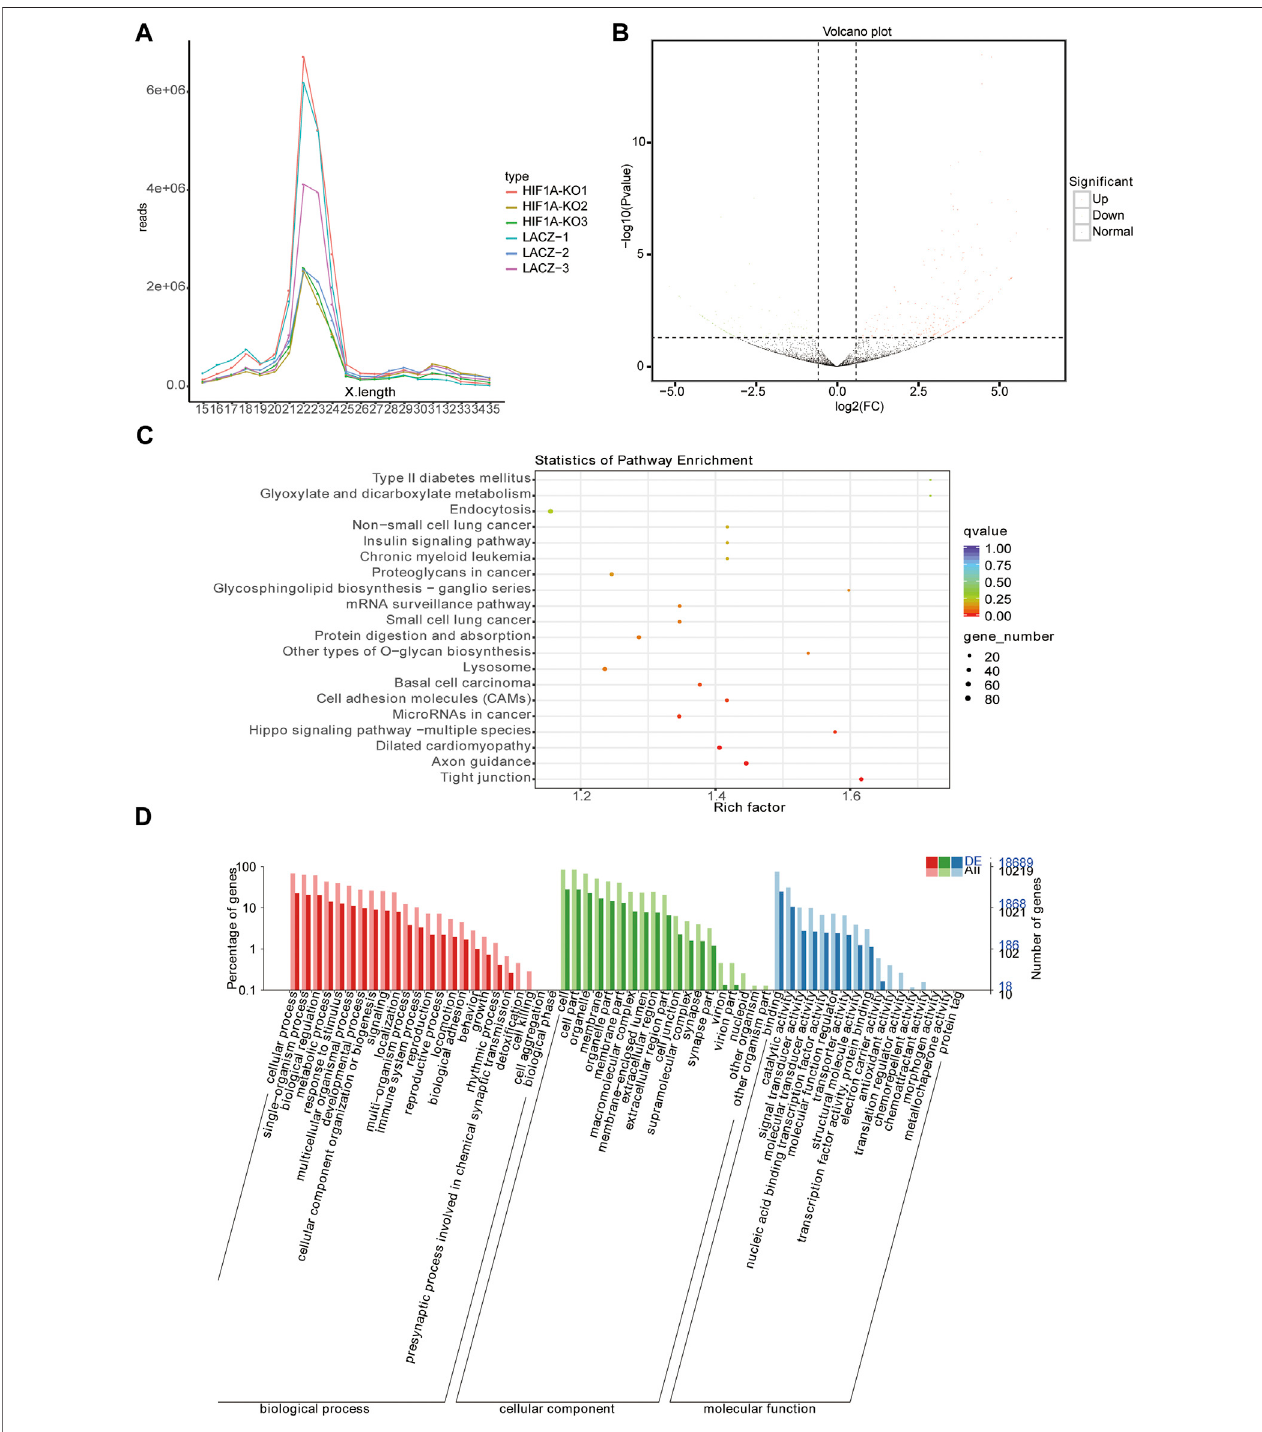
FIGURE 4 | Analysis of miRNA-seq. (A) Length distribution of miRNAs in the six libraries. (B) Volcano plot displaying miRNA expression alterations in HIF1A-KO cells compared to those of the control. (C) Top 20 KEGG pathways enrichment of DEMs. (D) GO analysis of DEMs through diverse GO categories.